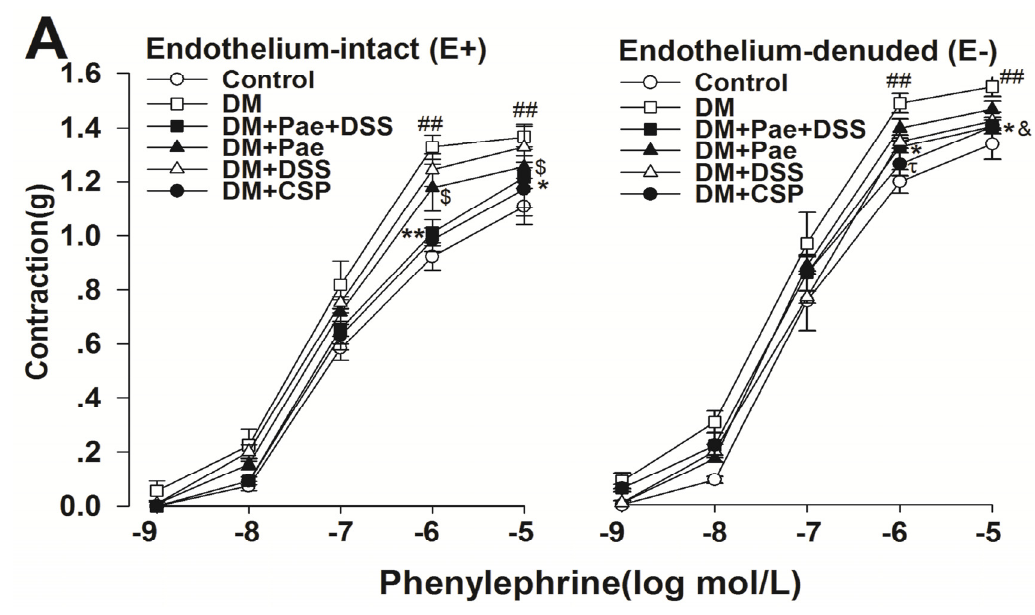
Figure 4. Contractile responses to Phenylephrine (PE) obtained from cerebral artery rings in all groups. ( A ) Concentration–response curves of PE obtained in E+ or E − rings of cerebral arteries in all groups ( n = 5); ( B ) 1 µmol/L PE-induced contractile responses in E+ or E − rings of cerebral arteries in all groups ( n = 5); ** p < 0.01 and * p < 0.05 compared with the corresponding DM group, ## p <0.01 compared with the corresponding control group, $ p < 0.05 compared with the corresponding DM group, & p < 0.05 compared with the corresponding DM group, and ψψ p < 0.01 and ψ p <0.05 compared with the corresponding E+ group. Results are given as the mean ± SEM of three independent